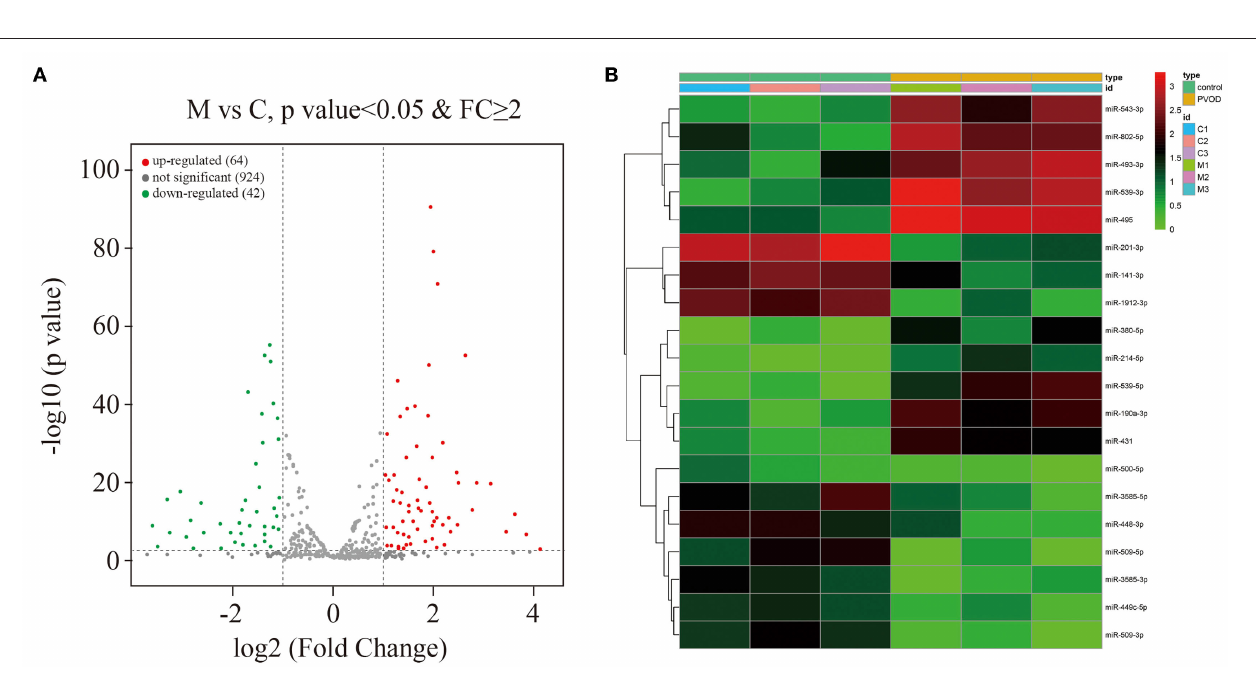
FIGURE 6 | The protein expression of GCN2 in rat. (A ) Western blot band of proteins expression. (B) Relative quantitative of GCN2 expression in the control group and the PVOD group. Values are expressed as means ± SD. GCN2, general control non-derepressible 2; PVOD, pulmonary veno-occlusive disease. The control group ( n = 4 rats) and the PVOD group ( n = 10 rats).